Question: In a single sentence, describe what this figure presents.
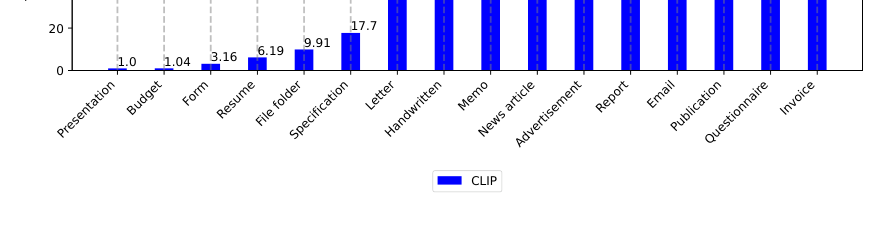
Answer: Rank ordering of class-wise top-1 accuracies obtained from the frozen CLIP model, for the RVL-CDIP dataset. The top axis also shows the zone of the varying number of unseen classes in the incremental splits (SI i ).